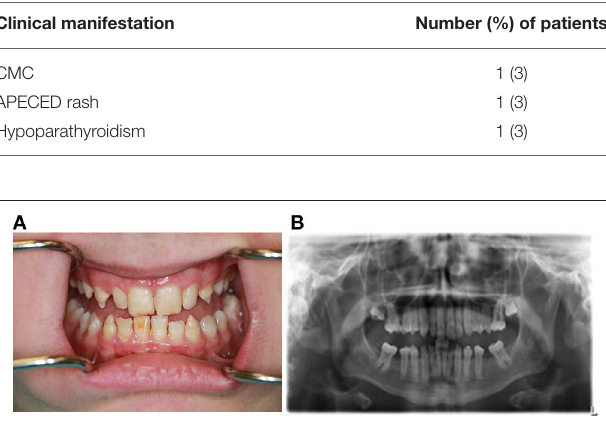
FIGURE 3 | Clinical intraoral photograph and panoramic radiograph of 15-year-old Caucasian male APECED patient demonstrating abnormal dental development with enamel hypoplasia (photo, A ), taurodontism (radiograph, B